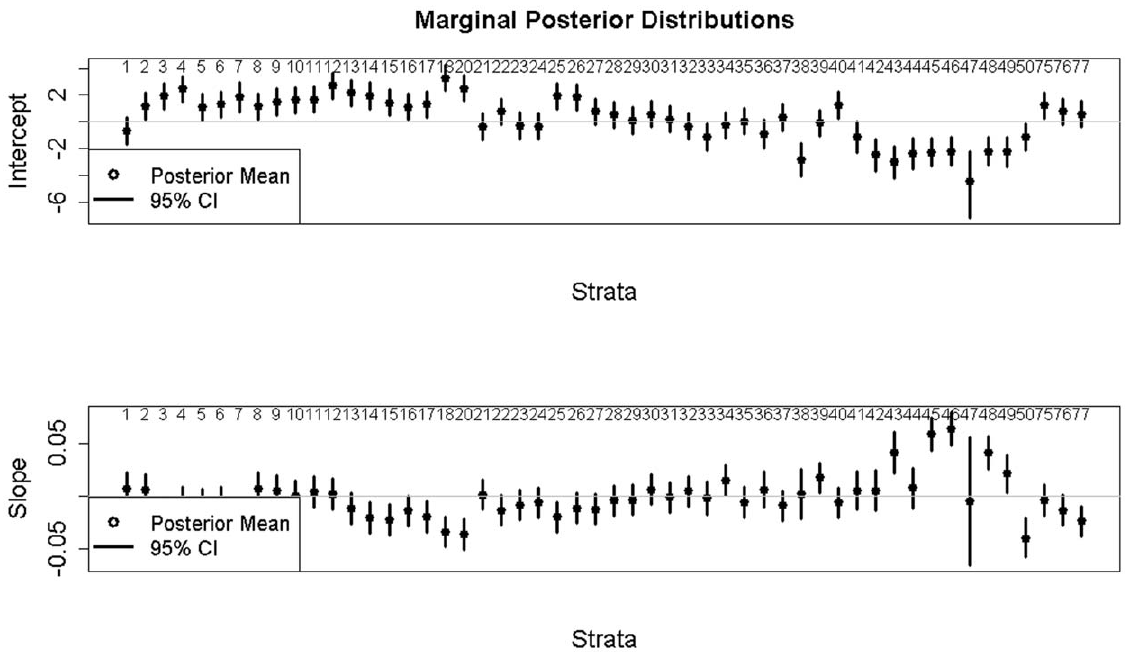
Figure 2. Marginal posterior distributions for the b coefficients controlling for general trend using the zero-inflated negative binomial data model.